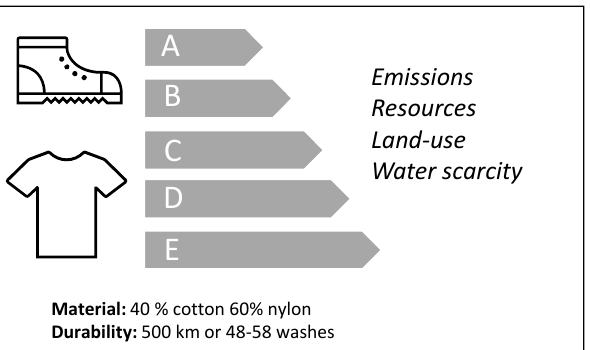
Figure 1. Suggestion of simple communication with consumers adapted from [14–16].